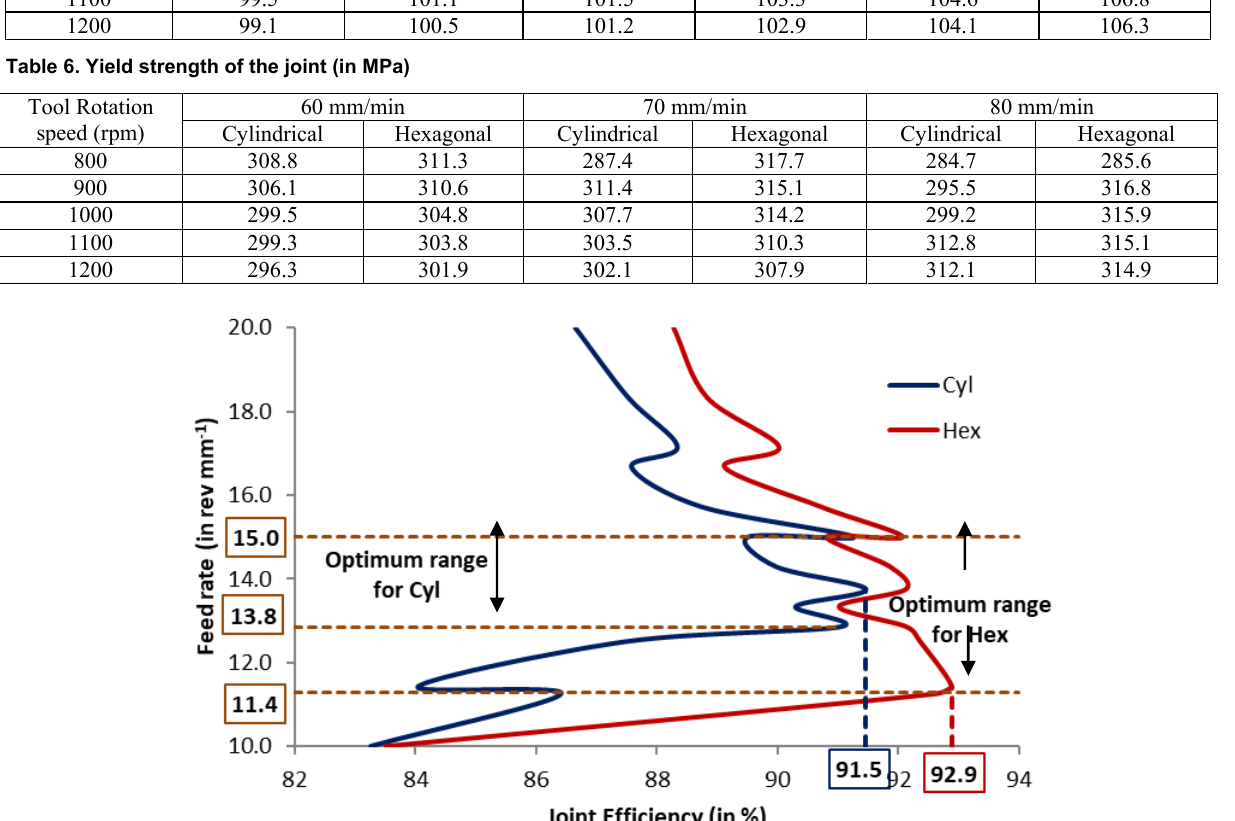
Figure 6. Optimum feed